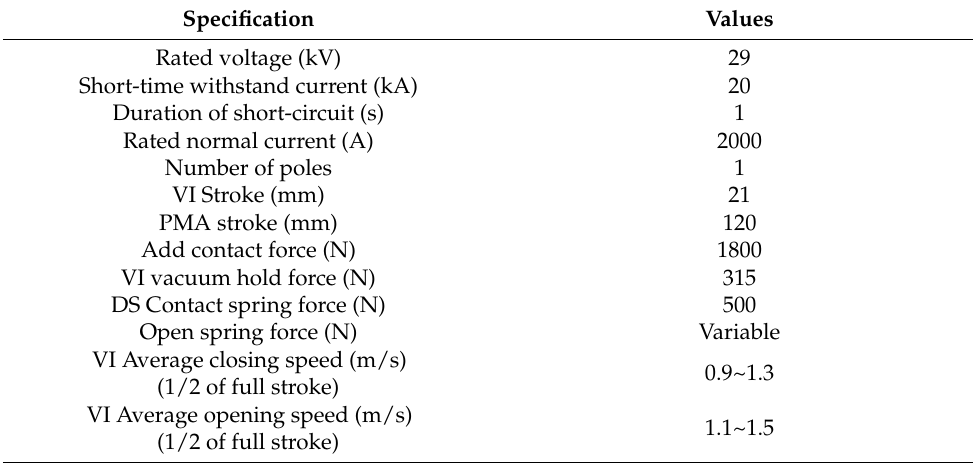
Table 2. Specifications of designed product.